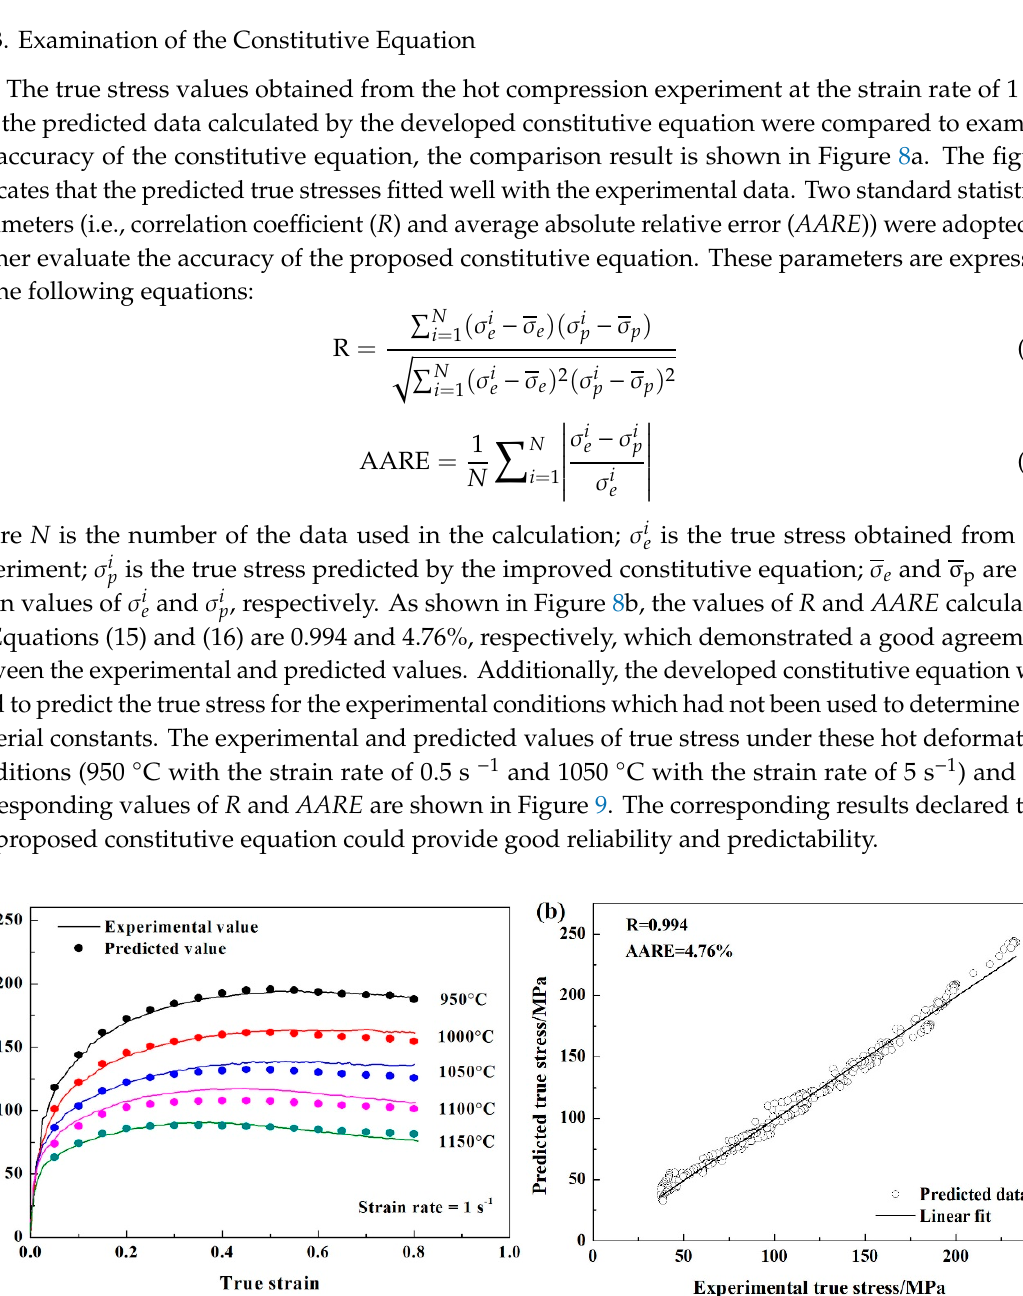
Figure 9. Comparison between the experimental and calculated true stress under the conditions of 950 °C with the strain rate of 0.5 s − 1 and 1050 °C with the strain rate of 5 s -1 . 3.3. Processing Map 3.3.1. Theory of the Processing Map A processing map is widely used to predict the microstructure evolution mechanism during hot compression, optimize the hot working parameters and indicate the “unsafe” regions in hot deformation process. A processing map is established by superimposing the instability map on the power dissipation map, which is based on DMM. The DMM considers the workpiece in hot working as a power dissipator, and the total energy ( P ) absorbed by the workpiece during hot working is composed of two complementary parts: the dissipative content G and the dissipative co-content J . G represents the energy for the increase in temperature during hot deformation, while J denotes the energy for metallurgical process, such as DRV, DRX, flow localization, etc. [18]. Therefore, the relationship between these energies can be described by the following equation: